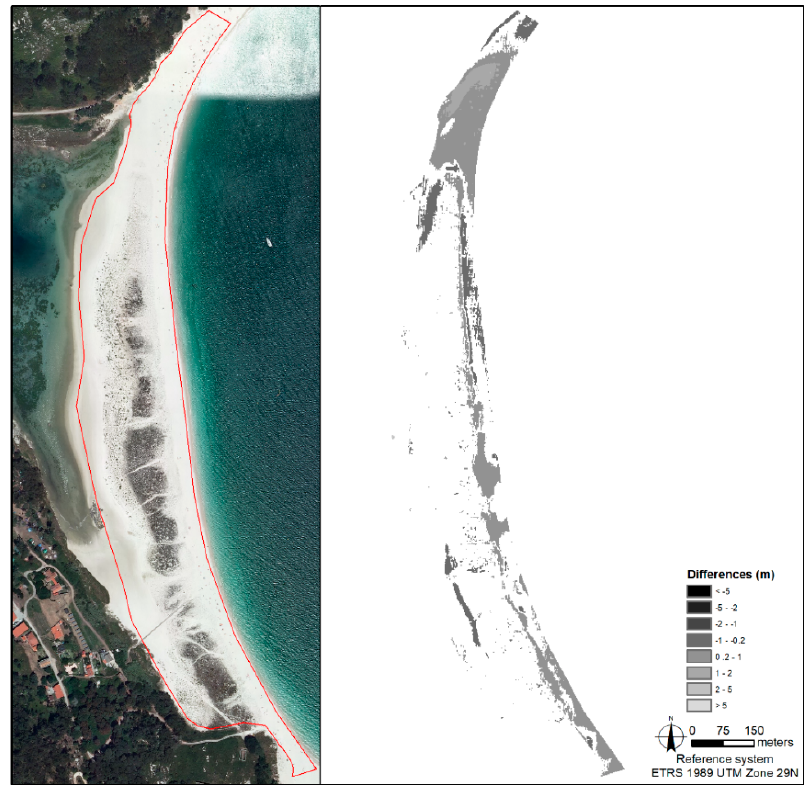
Figure 7. GCD Analysis: The right part represents the study zone (red polygon) in the orthophotograph. The left side represents the elevation variations in the